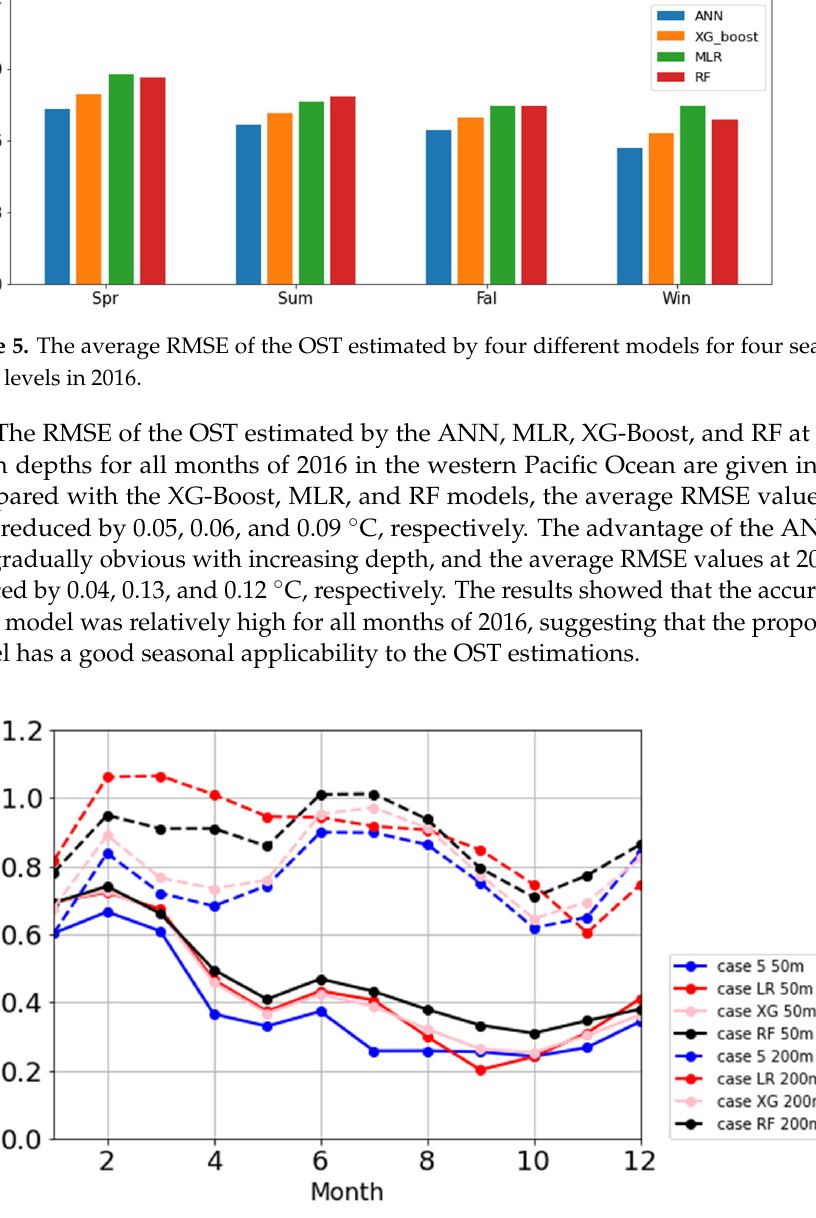
Figure 6. The RMSE of each case at 50 m (solid line) and 200 m (dashed line) depth.